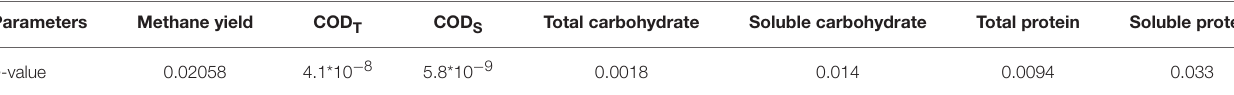
TABLE 2 | Summary table of the one-way ANOVA for experiment data. Parameters Methane yield COD T COD S Total carbohydrate Soluble carbohydrate Total protein Soluble protein p